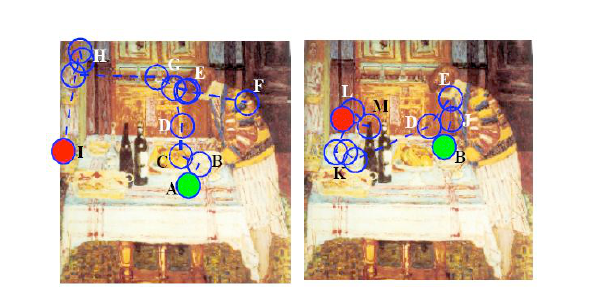
Figure 3. A sequence of eye fixations can be represented by a string of letters with each letter corresponding to a different region of interest. In the two examples here reported (see also Fig.1); we have on the left a total of thirteen fixations that can be condensed and represented by the string ABCDEFEGHI and, on the right, a total of ten fixations represented by the string BJEDKLML . Fixation strings are then used by two metrics Sp and Ss for comparing the spatial distribution and ordering of different viewing session scanpaths.